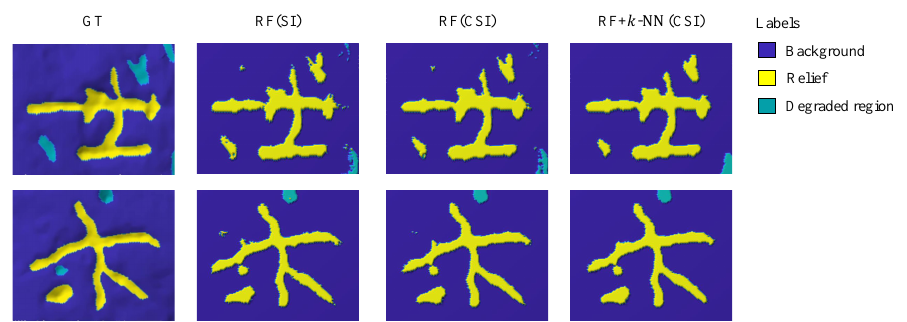
Figure 11. Subjective comparison of the classification results before re-labeling. The second and third columns were obtained using the RF models trained using SI and CSI, respectively. The fourth column was obtained after applying k -NN to the third column. The k -NN fills the holes and gets rid of isolated